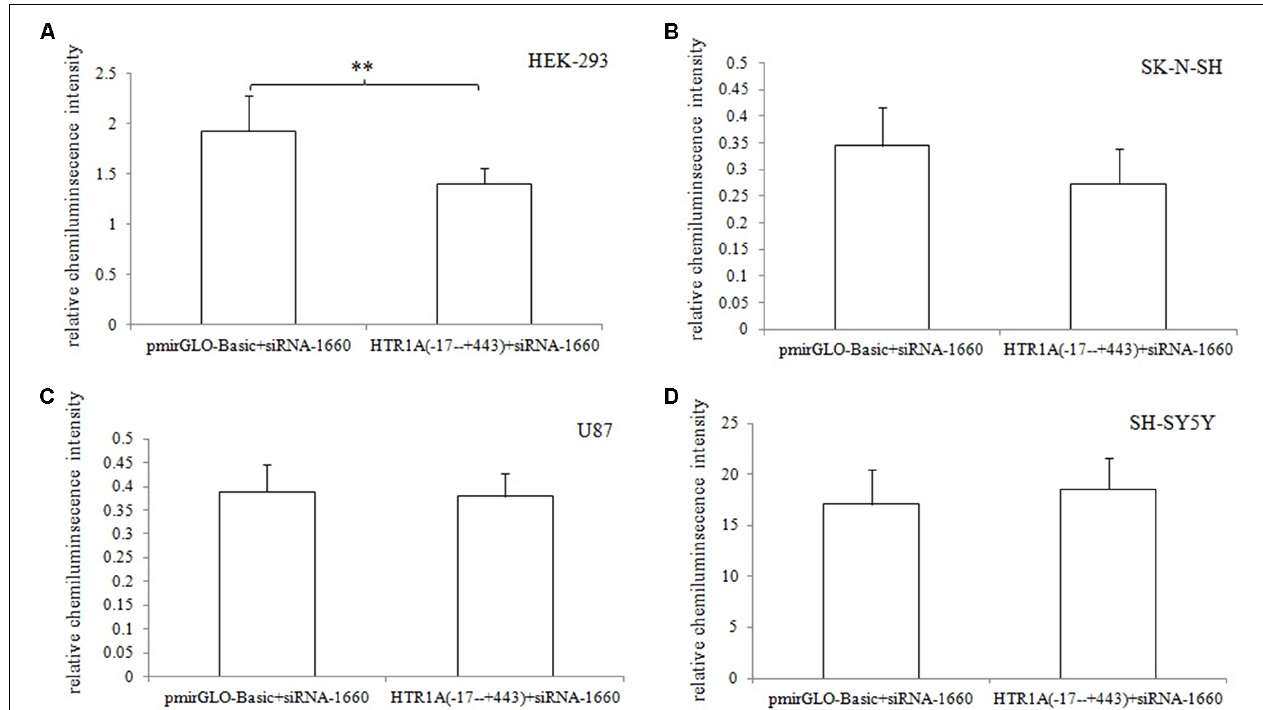
FIGURE 1 | Effect of the Dicer knock-down on the inhibitory function of 3 (cid:48) -UTR sequence (A–D) . When the endogenous Dicer enzyme of the four cell lines were knocked down, we found that the inhibition of the 3 (cid:48) -UTR sequence was not significant in SK-N-SH and U87 cells. The results indicated that the down-regulation of gene expression by the 3 (cid:48) -UTR sequence might be exerted by the Dicer-mediated miRNAs. ∗∗ 0.001 ≤ p < 0.02.